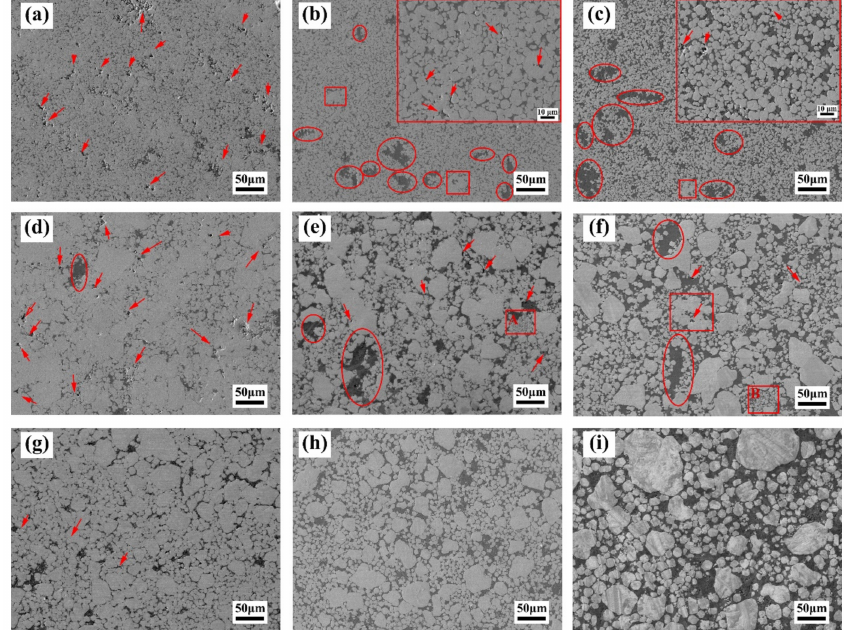
Figure 5. Microstructure of the ( a ) WY–050–10Cu, ( b ) WY–050–15Cu, ( c ) WY–050–20Cu, ( d ) WY–G–10Cu, ( e ) WY–G–15Cu, ( f ) WY–G–20Cu, ( g ) WM–G–10Cu, ( h ) WM–G–15Cu, and ( i ) WM–G–20Cu compos- ites. The red arrows indicate the enclosed pores; the red circles indicate the Cu-rich regions; the red rectangles indicate the agglomerated W